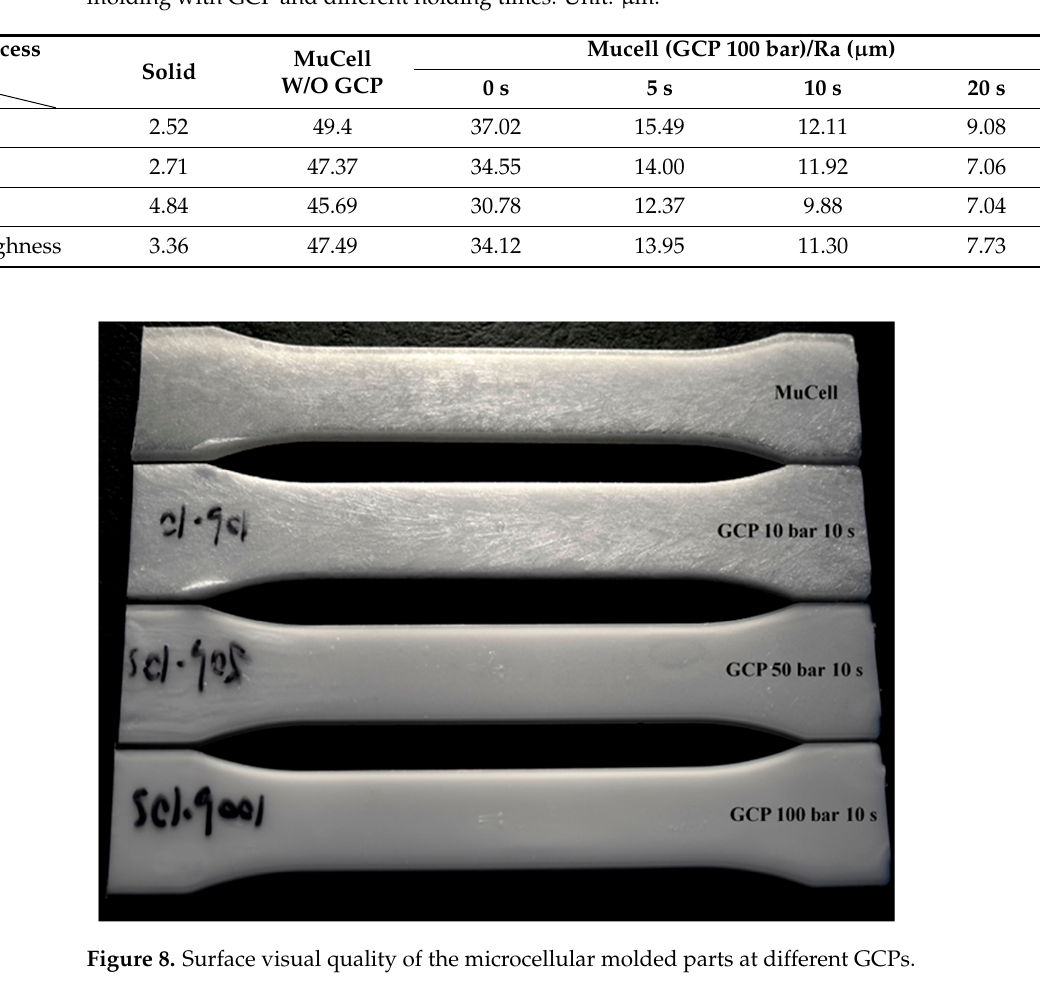
Table 4. Surface roughness measurements at gate, mid, and flow end both for solid/microcellular molding with GCP and different holding times. Unit: μ m.